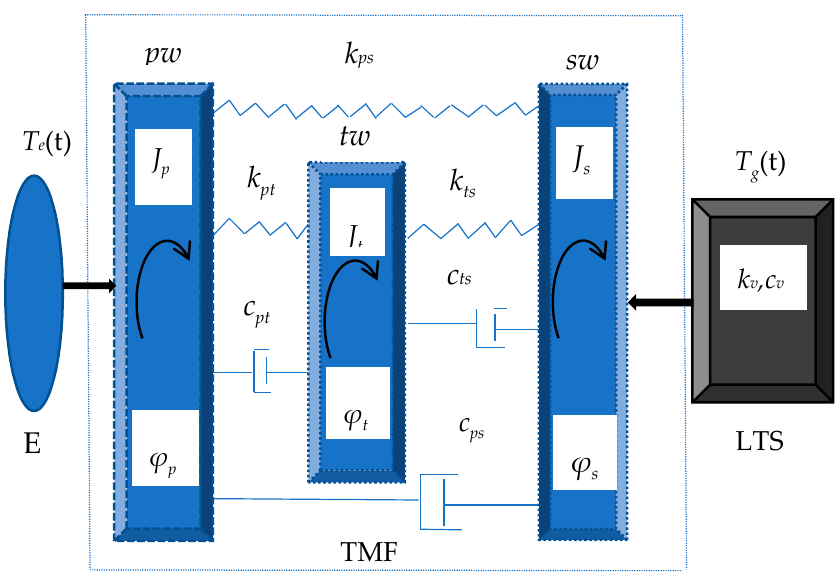
Figure 1. A schematic illustration of a portion of a vehicle drivetrain with a triple mass flywheel (TMF). LTS, load transmission system.